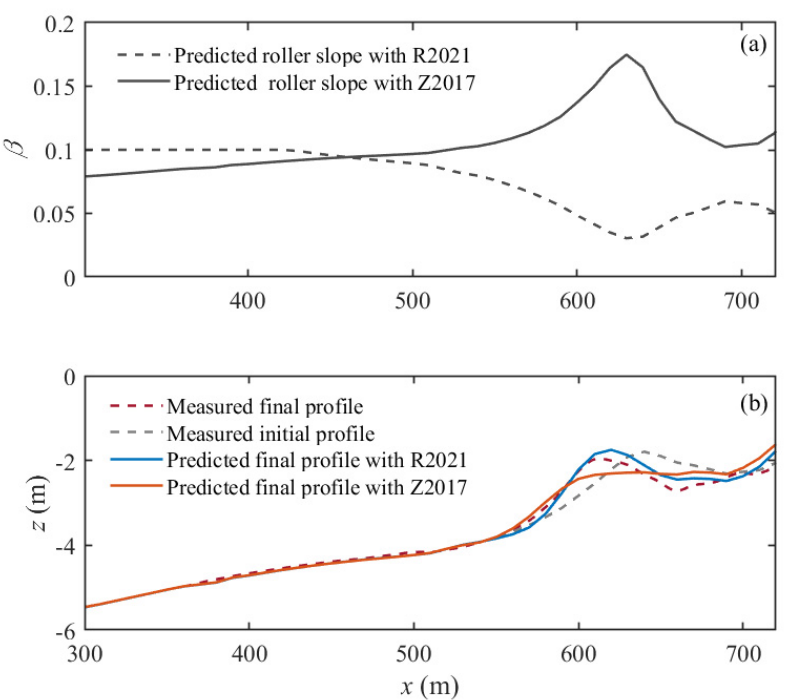
Figure 4. Comparisons of ( a ) roller slope and ( b ) beach profile evolution by using Z2017 and R2021.